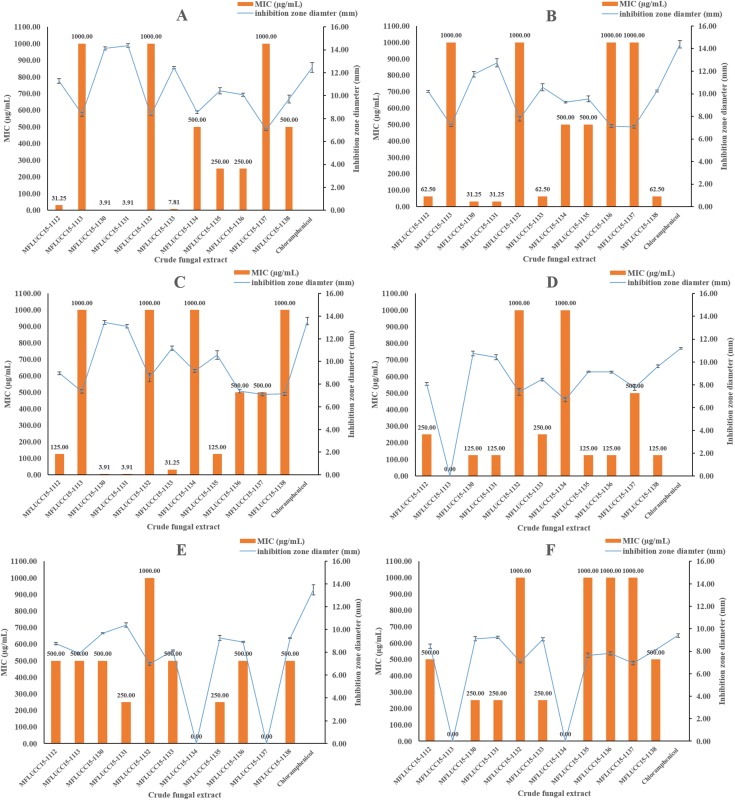
Antibacterial activities of crude fungal extracts and chloramphenicol against B. cereus (A), S. aureus (B), S. epidermidis (C), E. coli (D), P. aeruginosa (E), and S. typhimurium (F), expressed as an inhibition zone diameter and MIC.Each bar graph indicates the average inhibition zone diameter (mm) of crude fungal extracts and chloramphenicol at a concentration of 1,000 μg/mL and 20 μg/mL, respectively (triplicate analysis). No standard deviation value was obtained from this experiment. Each line represents the MIC (μg/mL) of crude fungal extracts against each bacterial pathogen tested. Each error bar was calculated from a standard deviation value derived from a triplicate experiment.